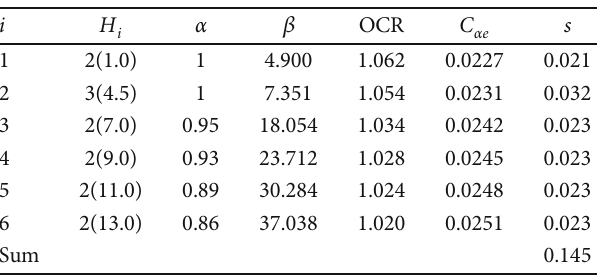
Table 3: Settlement calculation results.